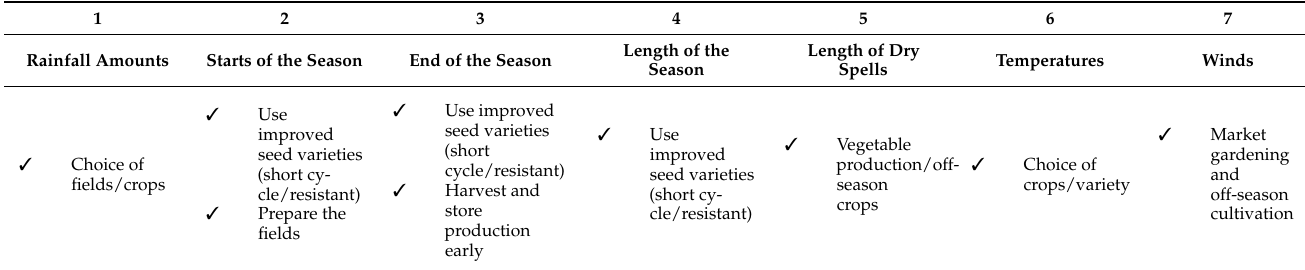
Table 5. Strategies to implement against a bad agropastoral